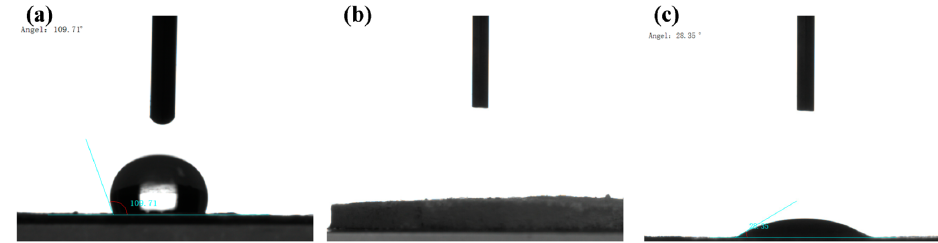
Figure 3. Contact angle with water of ( a ) PA; ( b ) PA-PEI; ( c ) CuBTC@PA-PEI. XRD measurements were conducted to determine the crystallinity of the